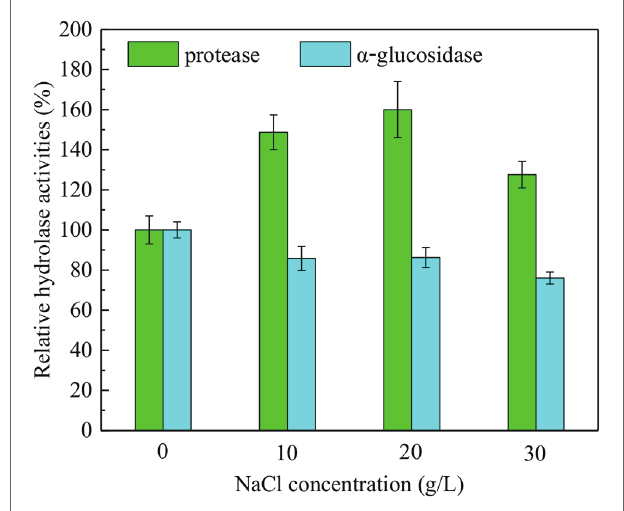
FIGURE 1 | Relative activities of protease and α -glucosidase after 4-day NaCl assistant anaerobic fermentation at the NaCl concentrations of 0 (control), 10, 20, and 30